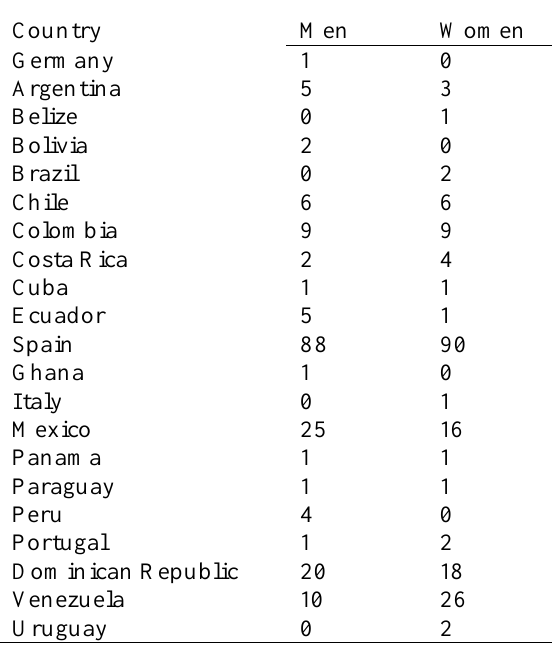
Distribution of